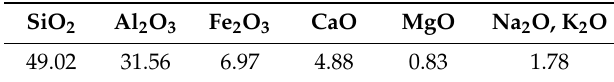
Table 3. Chemical composition of fly ash (%).